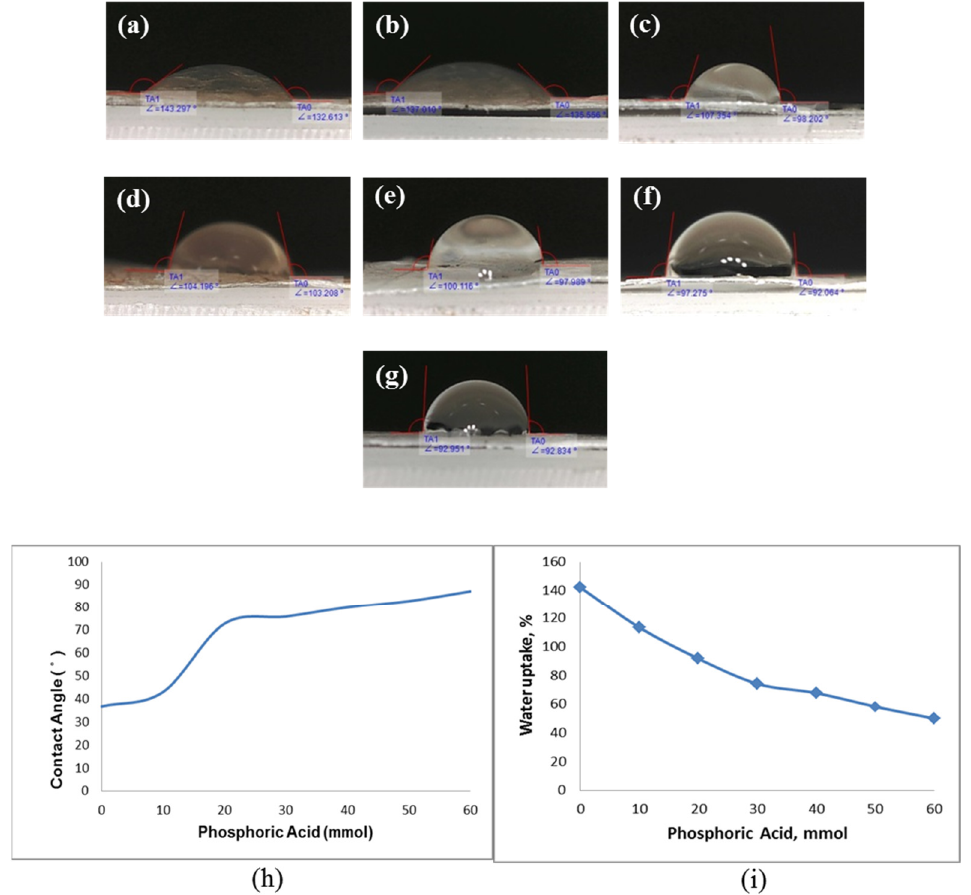
Figure 6. Contact angle of pure NdC and phosphorylated NdC: ( a ) pure NdC, ( b ) NdC10, ( c ) NdC20, ( d ) NdC30, ( e ) NdC40, ( f ) NdC50, and ( g ) NdC60; ( h ) effect of phosphoric acid treatment on contact angle of phosphorylated NdC; and ( i ) effect of phosphoric acid on water uptake of phosphorylated NdC.